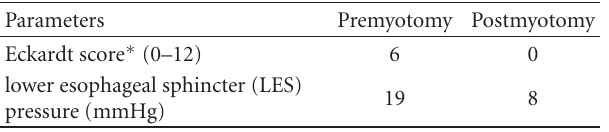
Table 1: Manometry findings and dysphagia score premyotomy and postmyotomy Month 6.